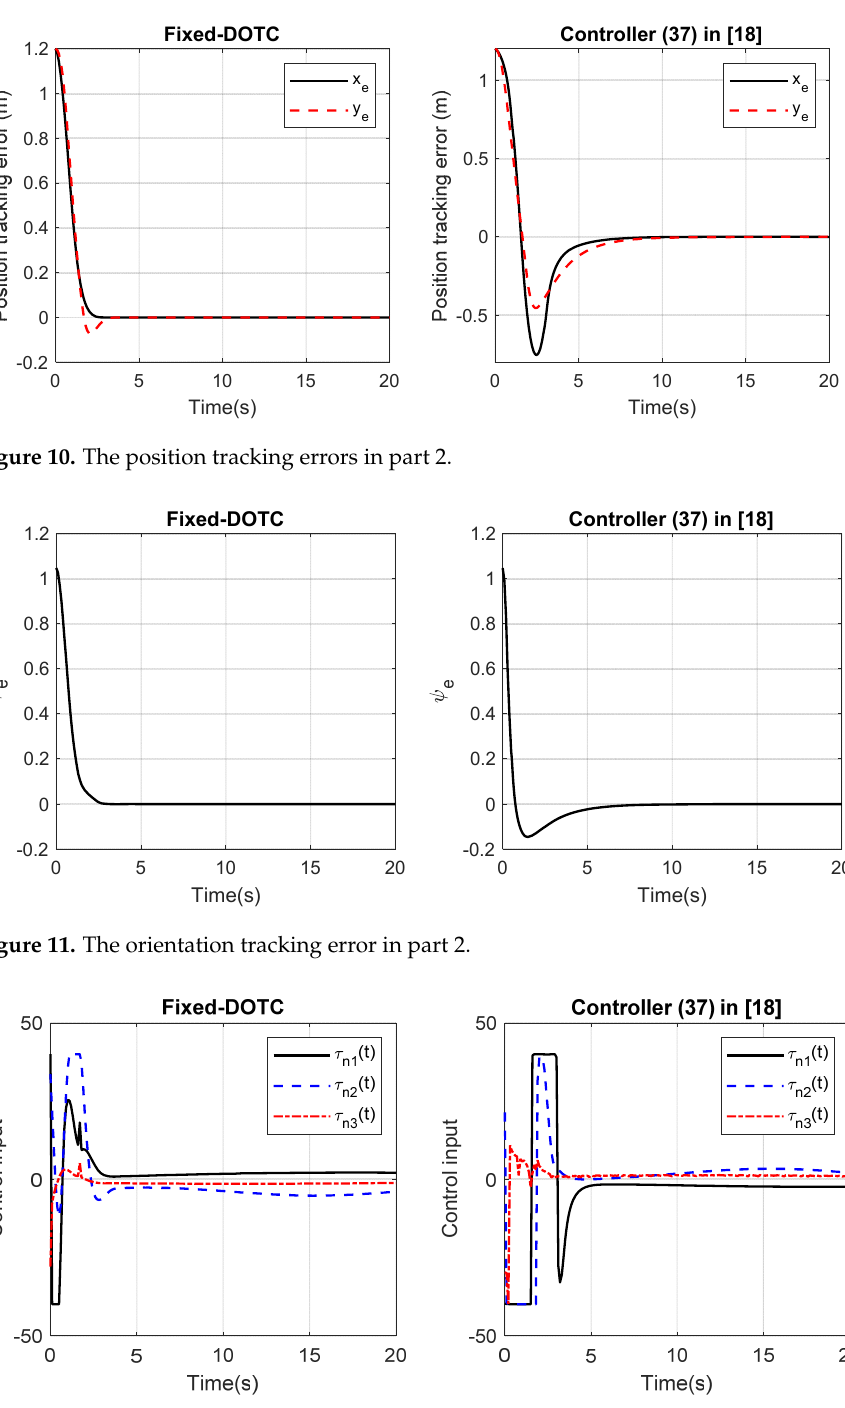
Figure 9. The actual position trajectory and the desired position trajectory in part 2.